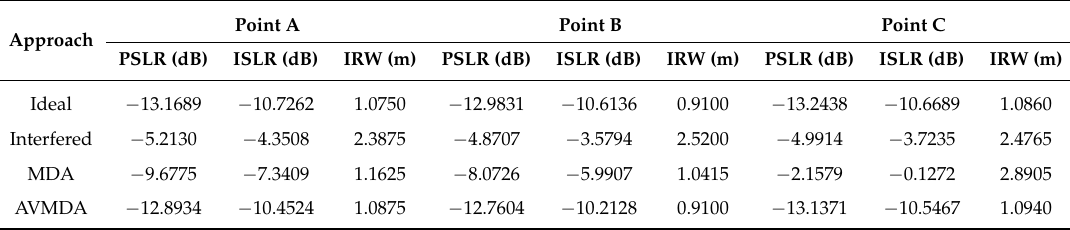
Table 3. Statistical focus comparison of ideal, azimuth-variant error interfered, MDA processed, and AVMDA processed simulated point targets.